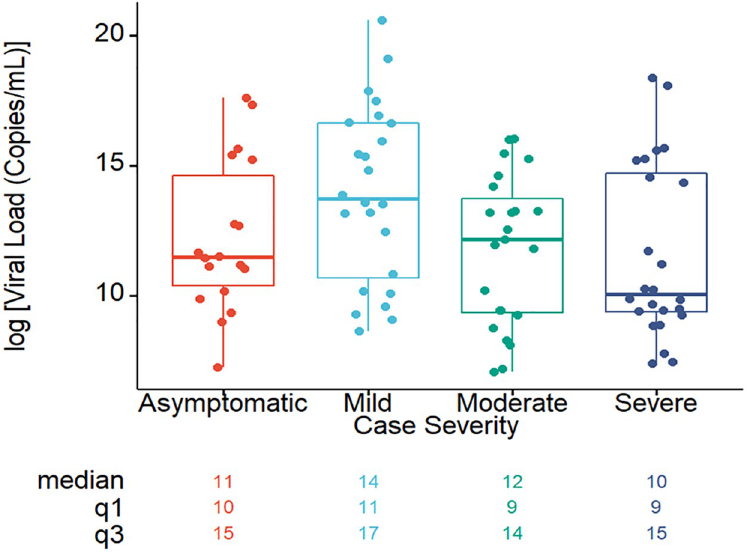
Fig 2. Viral load of COVID-19 patients with different severities during the study period. The SARS-CoV-2 viral load observed among patients with different severities on study day 0. The horizontal line inside each box represents the median value of the viral load copies/mL with interquartile ranges. The dots represent